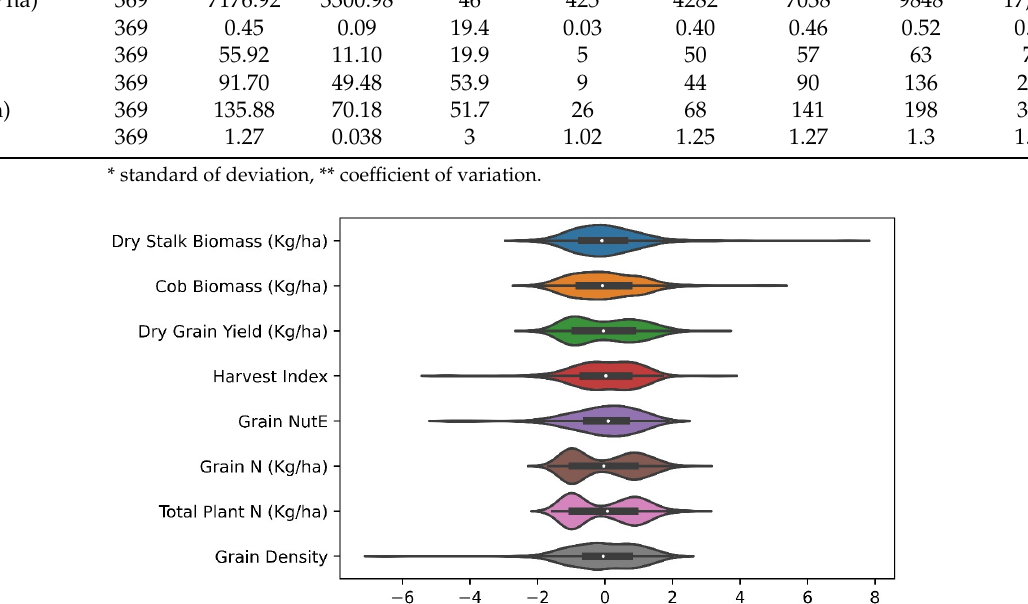
Figure 4. Standardized form of ground-truth data of eight maize phenotypes collected during the growing season. The means of all phenotypes after rescaling the distribution values were 0 and standard deviations were 1. Dry grain yield, grain nitrogen content, total plant nitrogen content displayed a binomial data distribution with no extreme instances. The other distributions looked normal but contained extreme values in their datasets.